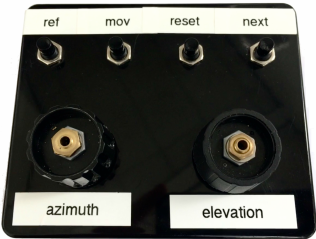
Figure 3. Physical controller designed for the auditory localization